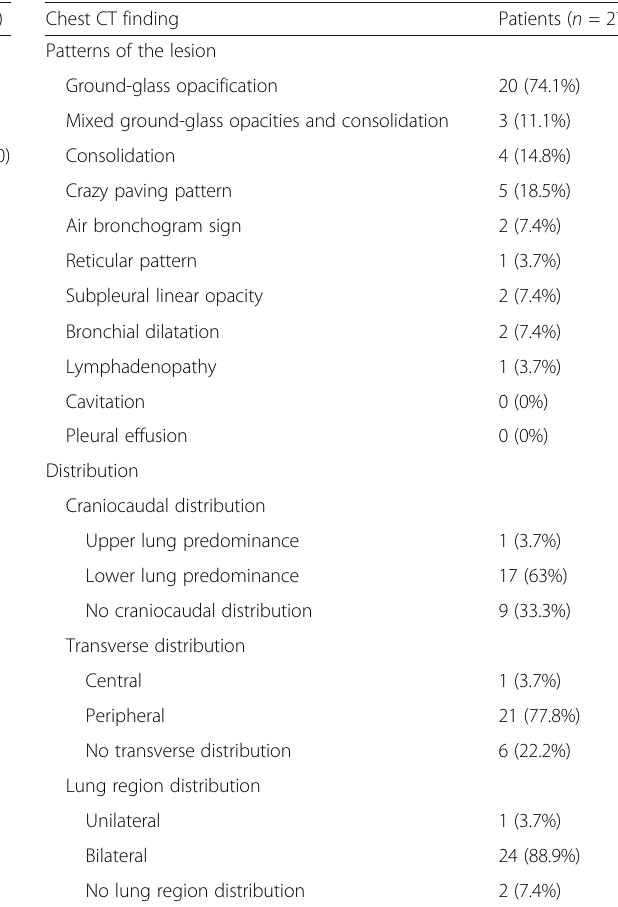
Table 1 Clinical characteristics and laboratory results patients with SARS-CoV-2 pneumonia